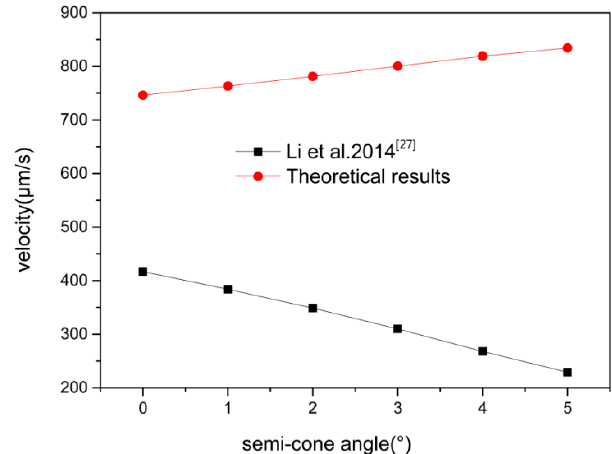
Figure 4. The velocity versus the semi-cone angle of the micromotor, the model used here is length L = 100 µ m, R max = 10 µ m, CH 2 O 2 = 5%, δ = 0 ◦ –5 ◦.